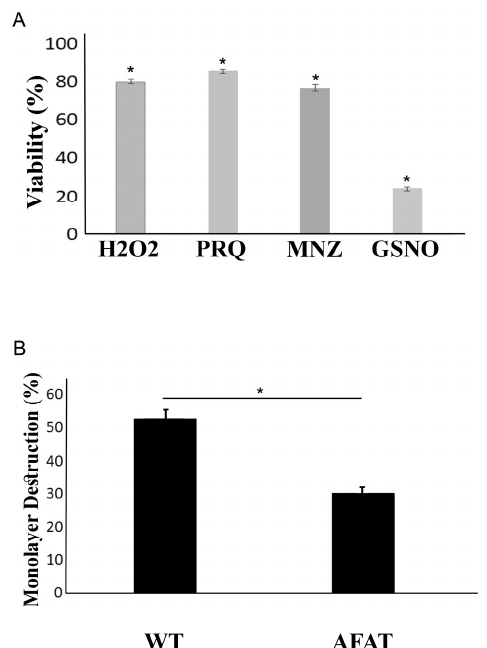
Figure 1. ( A ) Viability of AFAT exposed to H 2 O 2 , paraquat, MNZ, or GSNO. WT and AFAT were exposed to 2.5 mM H 2 O 2 for 30 min, 2.5 mM paraquat (PRQ) and 5 µ M metronidazole (MNZ) for 24 h, or 350 µ M GSNO for 2 h. All experiments were undertaken at 37 ◦ C. Data are expressed as the mean ± standard deviation of three independent experiments that were performed in triplicate. The graph represents the ratio percentage of viable amoebas compared to WT. The viability of AFAT exposed to H 2 O 2 , PRQ, MNZ, or GSNO was significantly different (* p < 0.05) from that of the WT according to the results of an unpaired Student’s t test. ( B ) Cytopathic activity of AFAT. Data are displayed as the mean ± standard deviation of four independent experiments that were performed in triplicate. The cytopathic activity of AFAT was significantly different (* p < 0.05) from that of the WT according to the results of an unpaired Student’s t